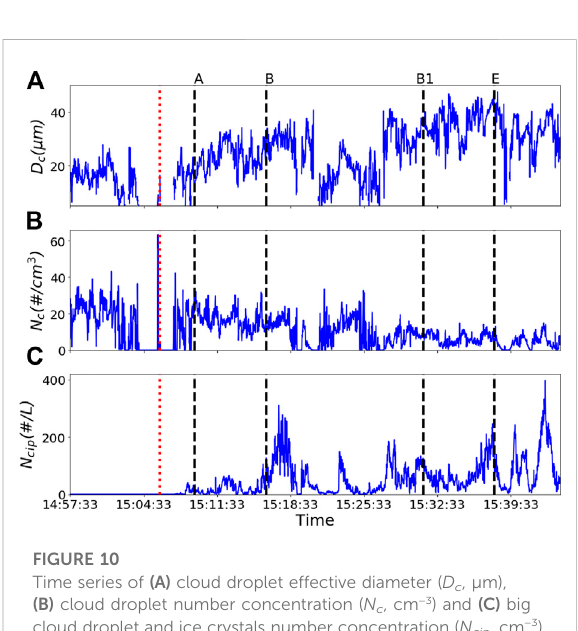
The red dotted line refers to seeding start time, the black dashed lines correspond to the routes of A-B and